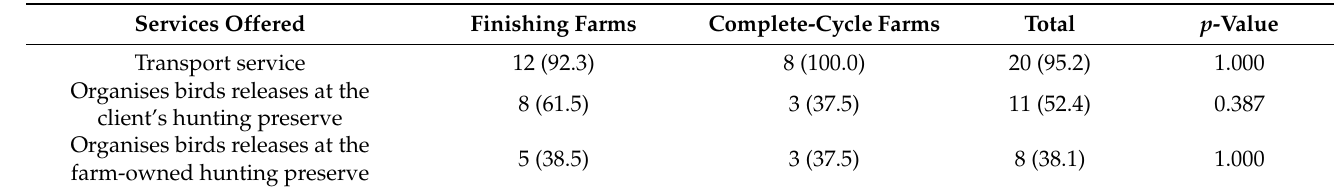
Table 7. Frequency (n, and % between parentheses) of additional services offered by quail game farms depending on farm type (n = 21).